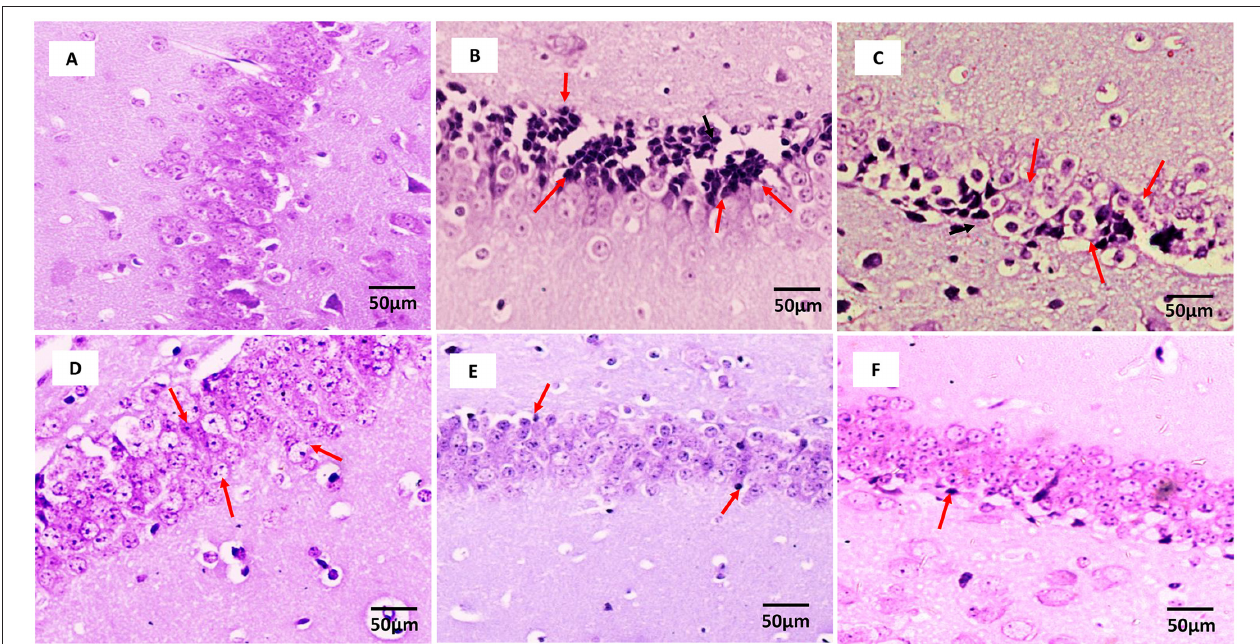
FIGURE 2 | Photomicrographs showing hippocampus of mice brain after treatment with vehicle, vehicle + PTZ, fisetin 5 + PTZ, fisetin 10 + PTZ, fisetin 20 + PTZ, and VPA + PTZ. Nissl staining was performed to illustrate structural changes and neuronal damage in the CA1 region of the hippocampus (40X). (A) In the control group, neurons are properly arranged and display proper edges with clearly visible cytoplasm. (B) Vehicle + PTZ group shows highly deranged hippocampal neurons which are loose with deeply stained cytoplasm. (C) Fisetin 5 + PTZ group mice brain showing distorted pyramidal cell layer and neurons with dark-colored cytoplasm as shown by arrows. (D) Fisetin 10 + PTZ group shows almost normal structural morphology similar to the control group as shown by arrows. (E) Fisetin 20 + PTZ group showed healthy cellular morphology of neuronal cells similar to the control group. (F) VPA + PTZ group showing normal histology of neuronal cells similar to groups (D,E) .